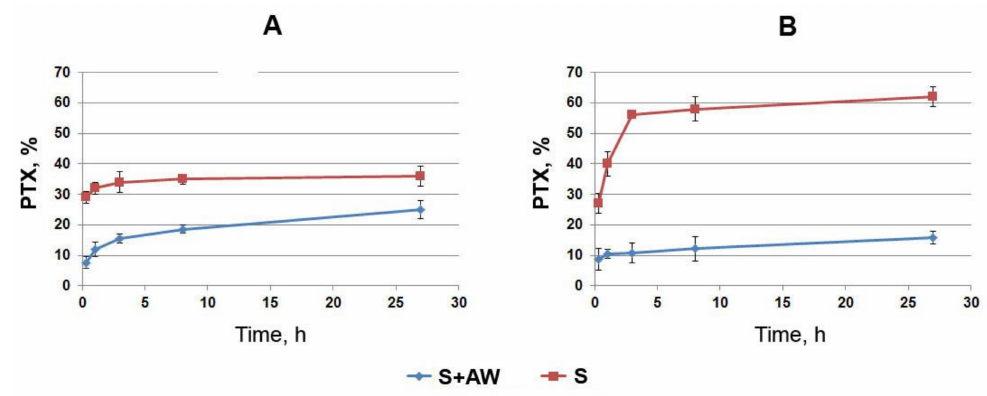
Figure 4. The kinetics of PTX penetration through the arterial wall. The PTX-eluting stents covered with the arterial wall (S+AW) or noncovered PTX-eluting stents (S) were incubated in ( A ) PBS or ( B )